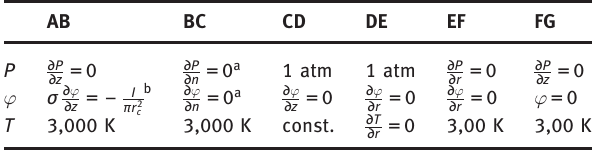
Table 1: Boundary